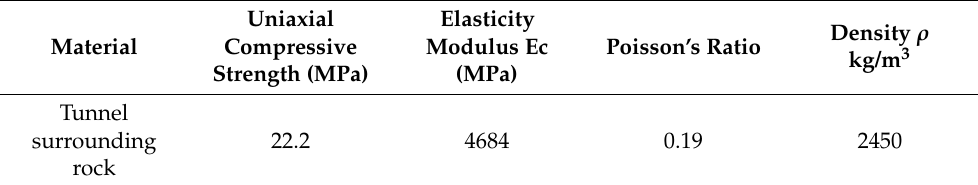
Table 1. Material parameters of tunnel surrounding rock.